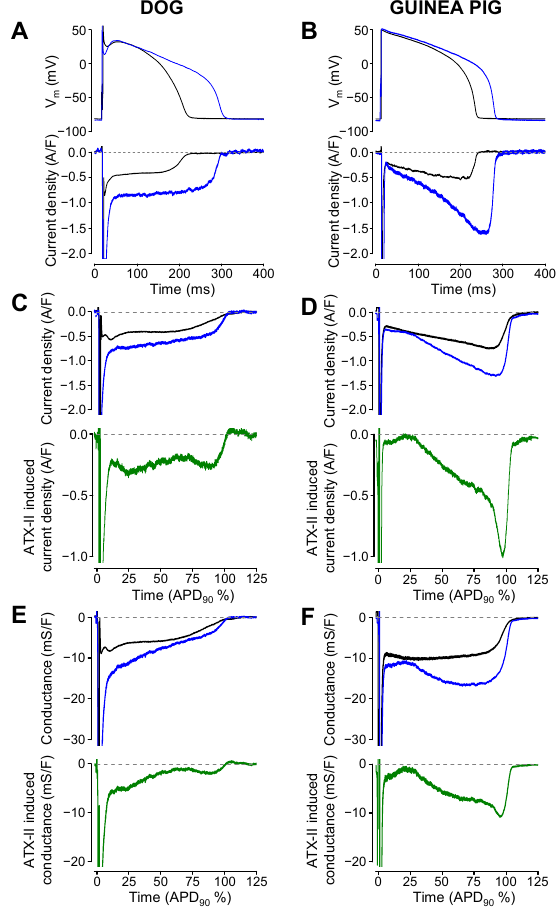
Figure 6. The effect of ATX-II on the TTX-sensitive current and conductance profiles in canine ( left ) and guinea pig ( right ) myocytes. ( A , B ) panels show representative APs and TTX-sensitive current records obtained before (black) and after (blue) the application of ATX-II (1 nM in dog and 10 nM in guinea pig). Average currents and conductances are shown using the same color code in panels ( C – F ). Average ATX-II induced currents ( C , D ) and conductances ( E , F ), obtained in six canine and four guinea pig myocytes, are displayed in a green